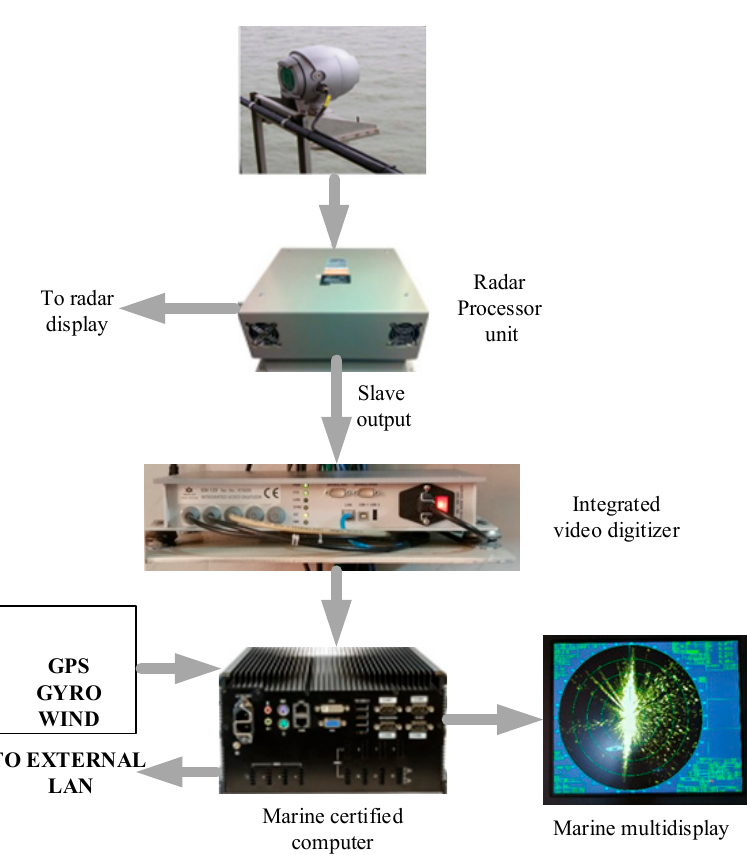
Figure 3. Diagram of the radar arrangement.